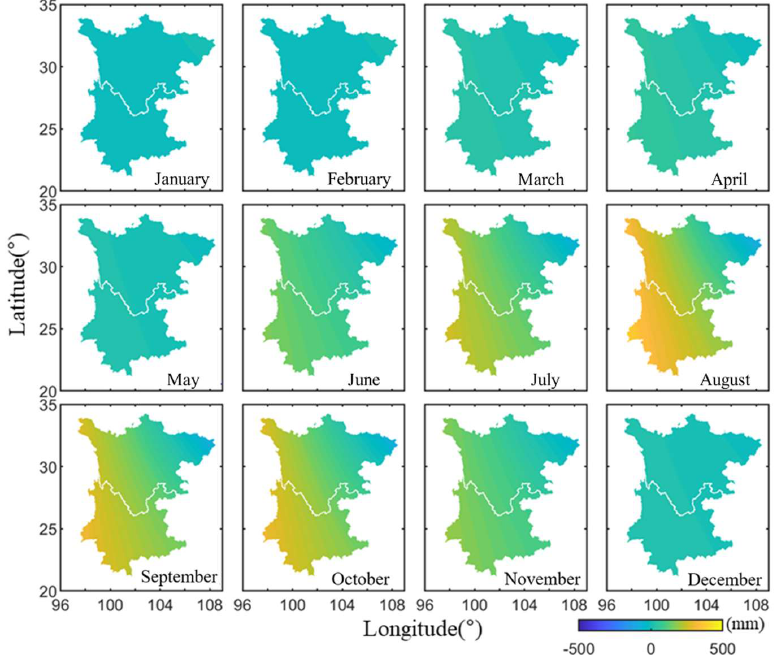
Figure 6. Monthly variations (2011) of the TWS in Sichuan-Yunnan estimated by GPS based on ICA.